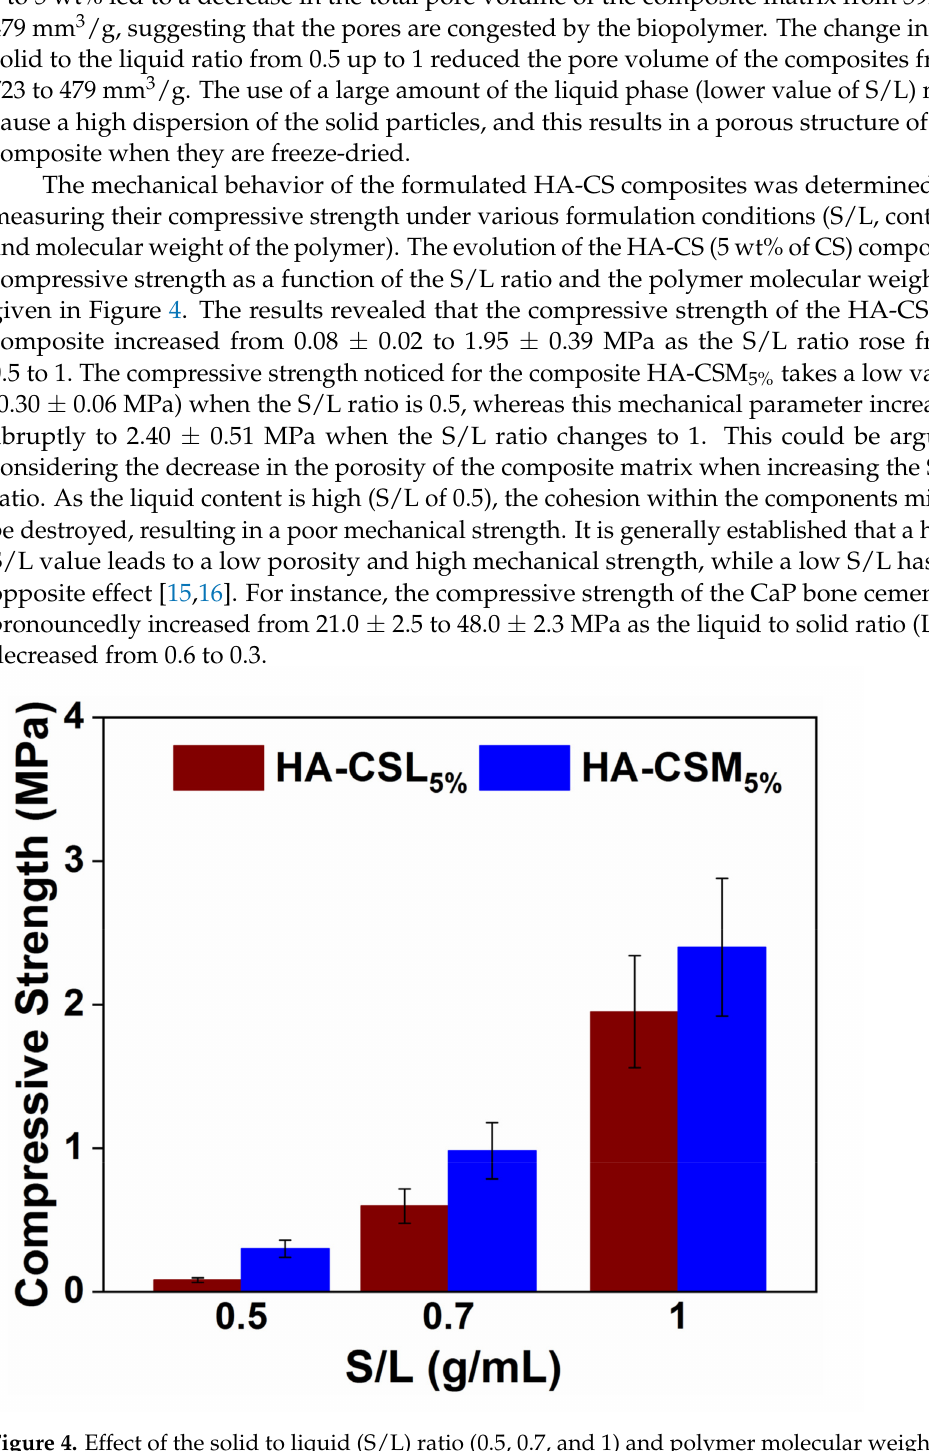
Figure 4. Effect of the solid to liquid (S/L) ratio (0.5, 0.7, and 1) and polymer molecular weight on the compressive strength of the HA-CSL 5% and HA-CSM 5% (5 wt% of CS)